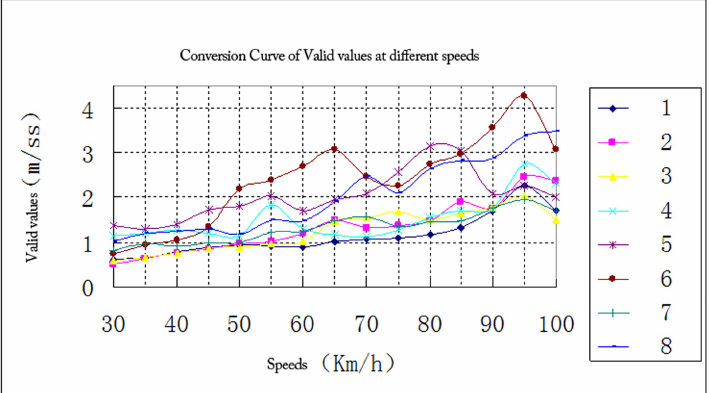
Fig. 6 Conversion curve of valid values at different